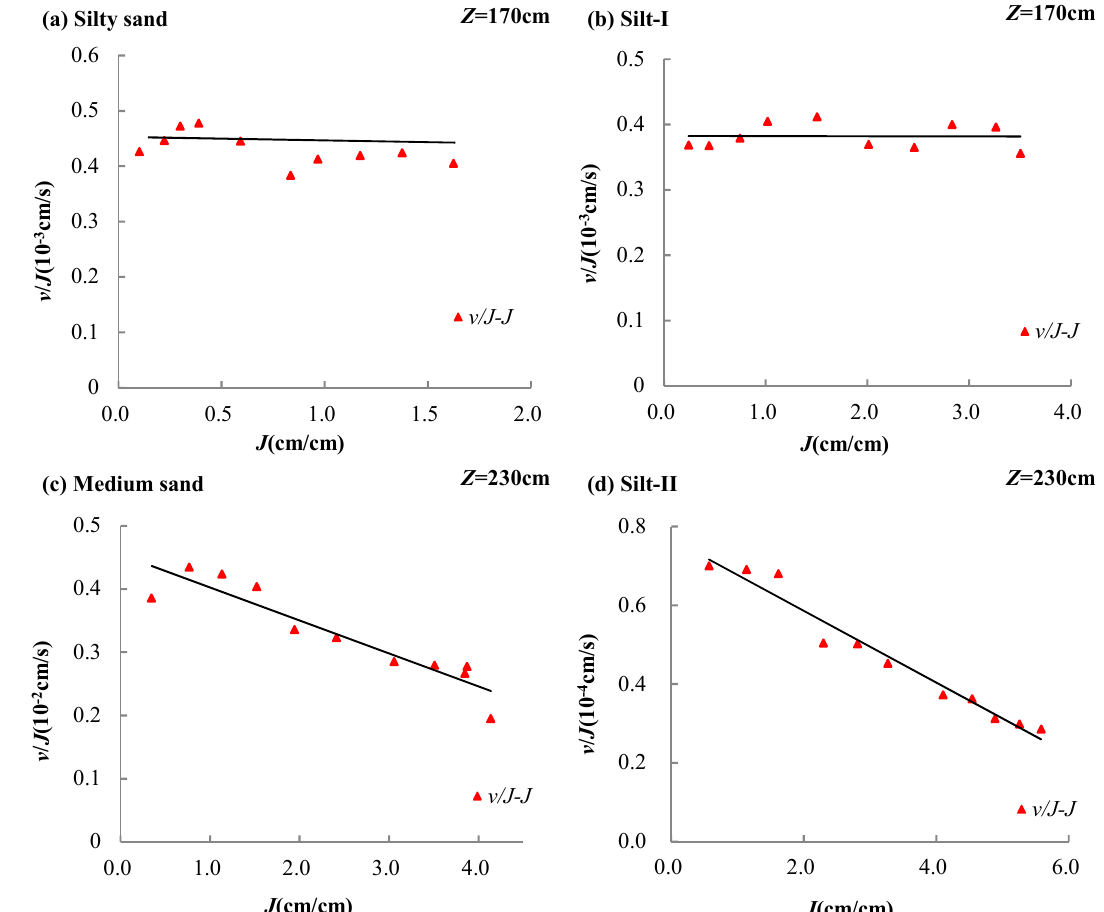
Figure 3. Variation of the ratio v / J with Reynolds number Re for four experimental media: ( a ) silty sand, ( b ) silt-I, ( c ) medium sand, and ( d ) silt-II. Note that the silty sand and silt-I were used under the constant hydraulic head of 170 cm, while the medium sand and silt-II were used under the constant hydraulic head of 230 cm. The black line represents a linear fitting curve.